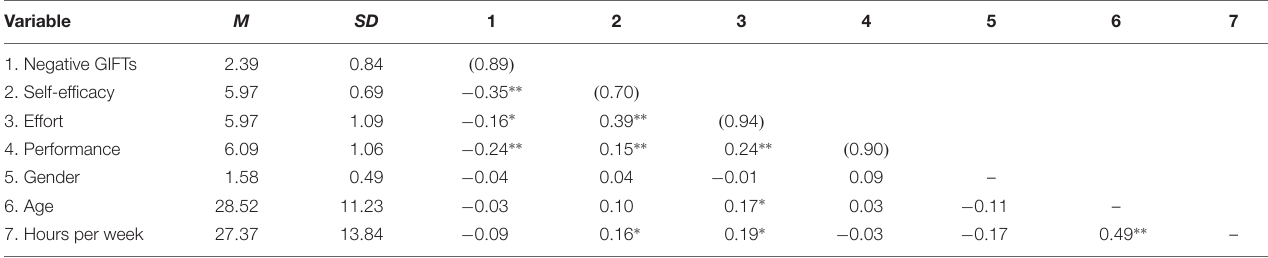
TABLE 1 | Means, standard deviations, reliability coefficients and correlations.